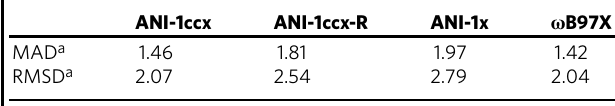
Table 1 Accuracy in predicting conformer energy differences on the GDB-10to13 benchmark